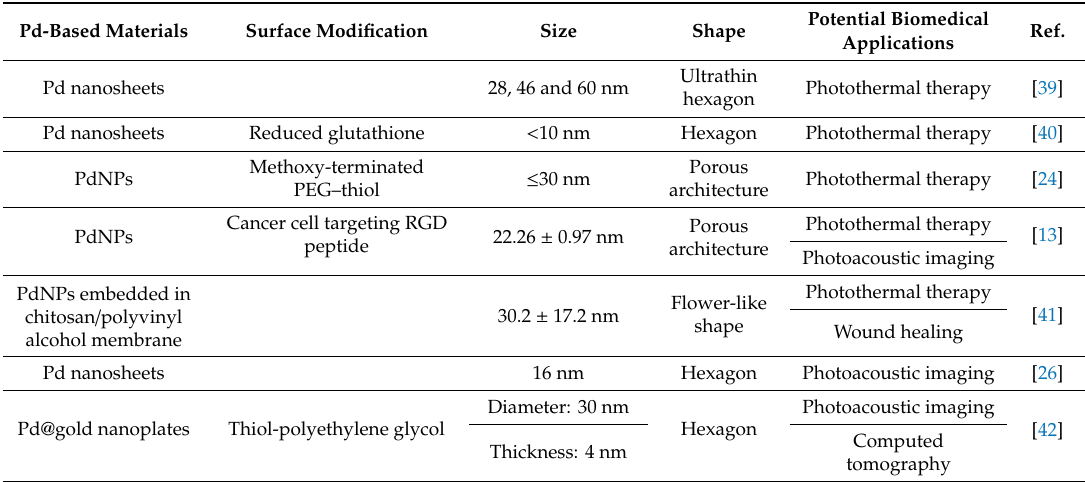
Table 1. Summary of the size, shape, and potential biomedical applications of reported